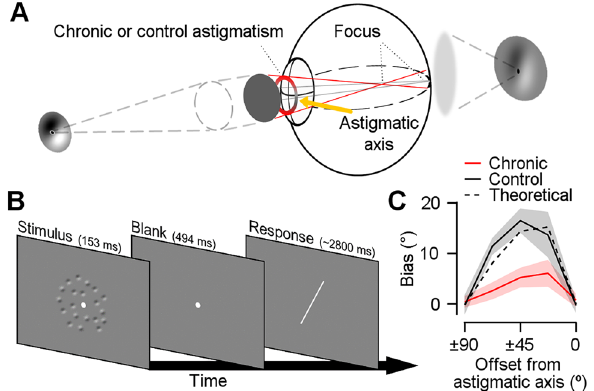
Figure 2. ( A ) Participants viewed a Gabor stimulus either with their own chronic refractive error (chronic group) or experimentally-induced astigmatic refractive error (control group). In both cases, a refractive power on the orthogonal axis is higher than on the astigmatic axis (yellow arrow). The circle in front of the eye indicates the refractive powers of each meridian (the higher refractive power is in red). This causes light rays from the Gabor stimulus to refract more at the orthogonal axis (red lines) than at the astigmatic axis (gray lines), shaping elliptical blur. As a result, the orientation of the Gabor stimulus in the retinal image tilts away from the astigmatic axis (horizontal). We controlled the experiment duration to prevent the participants from adapting to the optical environments. ( B ) A schematic of the orientation adjustment task. Randomly tilted Gabor stimuli were briefly presented at the center. After the post-stimulus blank, participants reported the perceived mean orientation by rotating the orientation bar. ( C ) The perceptual biases of the chronic group (red line), control group (solid black line), and prediction of the theoretical model (dashed black line) were plotted as a function of offset from the astigmatic axis. The shaded areas indicate ± 2 standard error of the mean (SEM).